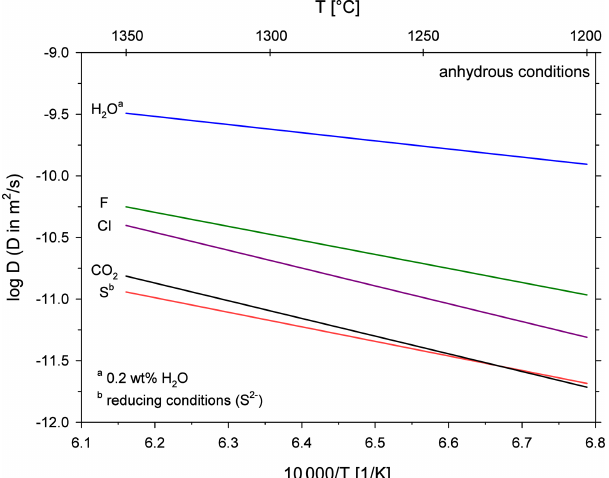
Figure 8. Arrhenius diagram for diffusion of different volatiles in depolymerized melts at anhydrous conditions; H 2 O diffusion in a basaltic melt from Zhang and Stolper (1991); F and Cl diffusion in a basaltic melt from Alletti et al. (2007); S diffusion in a basaltic melt from Freda et al. (2005); CO 2 diffusion in a leucititic melt from this study; Arrhenius equations for H 2 O, F, Cl and S are extrapolated to the temperature range of our study for better